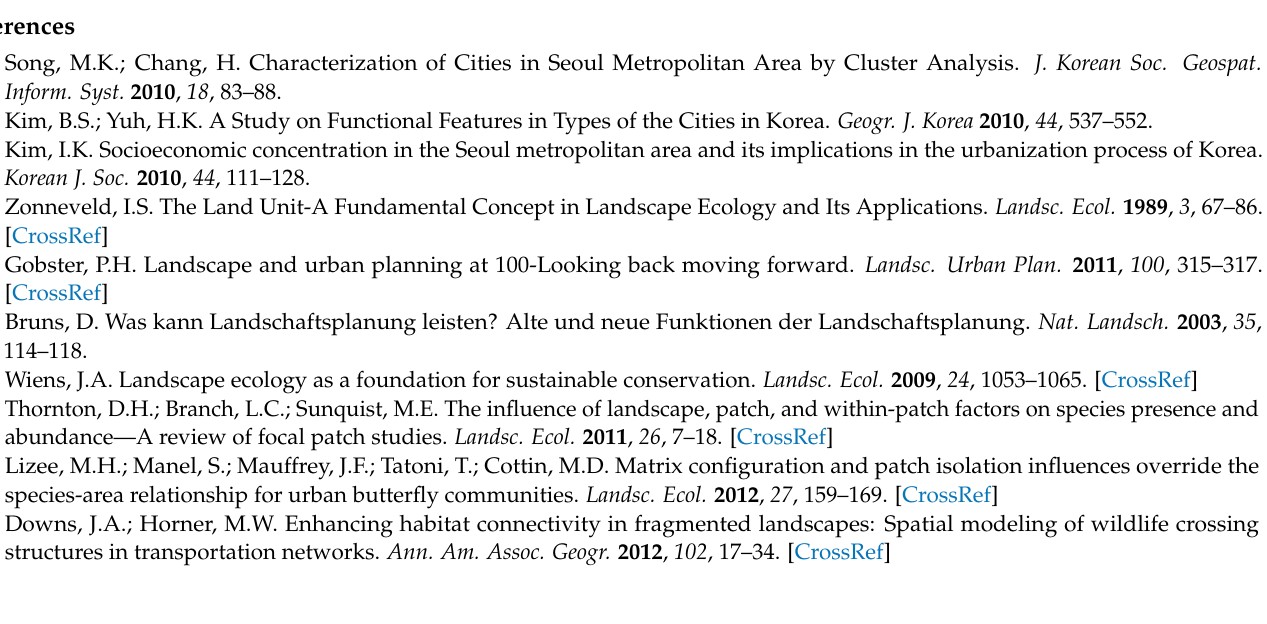
Figure A2. 2018 MSPA map of 31 cities.